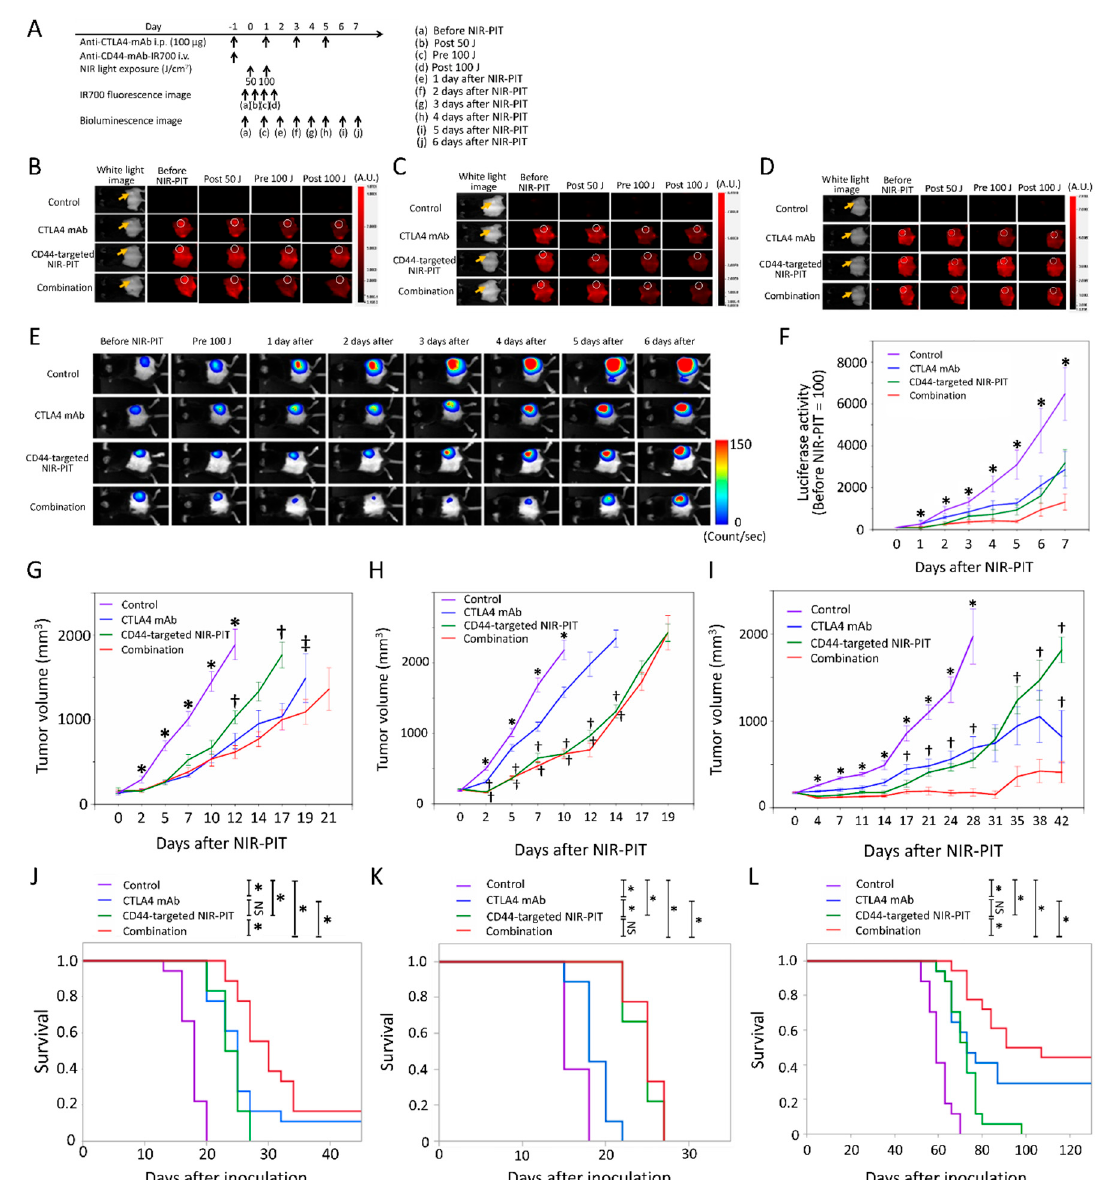
Figure 3. In vivo effects of CD44-targeted NIR-PIT and/or CTLA4 mAb administration for MC38-luc, LL/2, and MOC1 tumor models. ( A ) NIR-PIT regimen. Bioluminescence and fluorescence images were obtained at each time point as indicated. ( B – D ) Real-time in vivo IR700 fluorescence imaging of tumor-bearing mice before and approximately 10 min after NIR-PIT in MC38-luc ( B ), LL/2 ( C ) and MOC1 ( D ) tumor models. The yellow arrows and white circles indicate the tumor locations. ( E ) In vivo bioluminescence imaging of MC38-luc tumor-bearing mice before and after treatment at the indicated timepoints. ( F ) Quantitative analysis of luciferase activity before and after treatment in MC38-luc tumor-bearing mice. n ≥ 10/group, mean ± SEM; * p < 0.05, vs. the other groups; Dunnett’s test. ( G – I ) Tumor growth in all the groups for MC38-luc ( G ), LL/2 ( H ) and MOC1 ( I ) tumor models. n ≥ 9/group, mean ± SEM; * p < 0.05, vs. the other groups; Dunnett’s test; † p < 0.05, vs. combination group; Tukey–Kramer test; ‡ p < 0.05, vs. combination group; Mann–Whitney U test. ( J – L ) Survival curves in all the groups for MC38-luc ( J ), LL/2 ( K ) and MOC1 ( L ) tumor models. n ≥ 9/group; * p < 0.05; NS, not significant; Gehan–Breslow–Wilcoxon test.